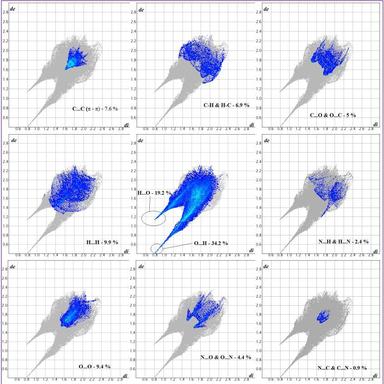
Fingerprint plots